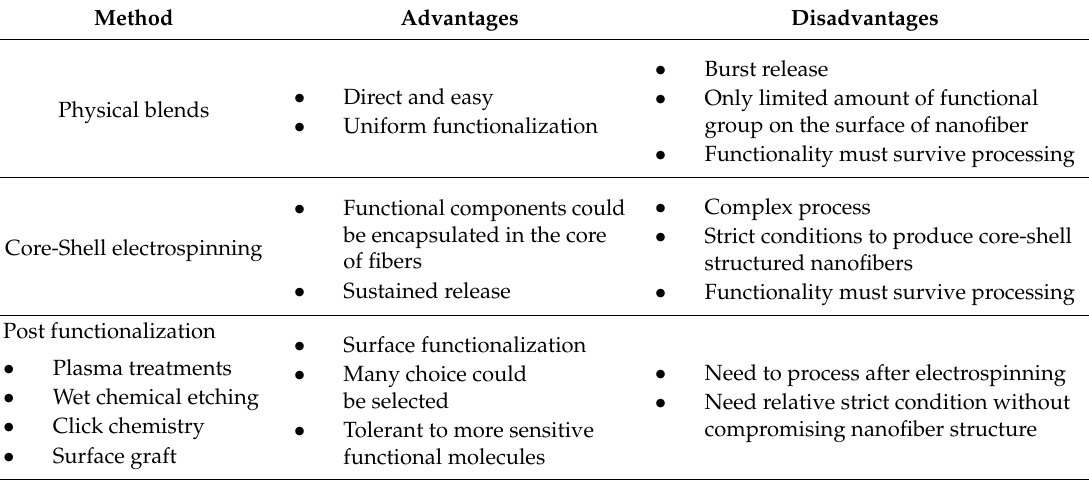
Figure 6. Functionalization approaches of electrospun nanofibers. ( A ) Physical blends, ( B ) core-shell electrospinning, and ( C ) post functionalization. Table 2. Comparison of methods for nanofiber